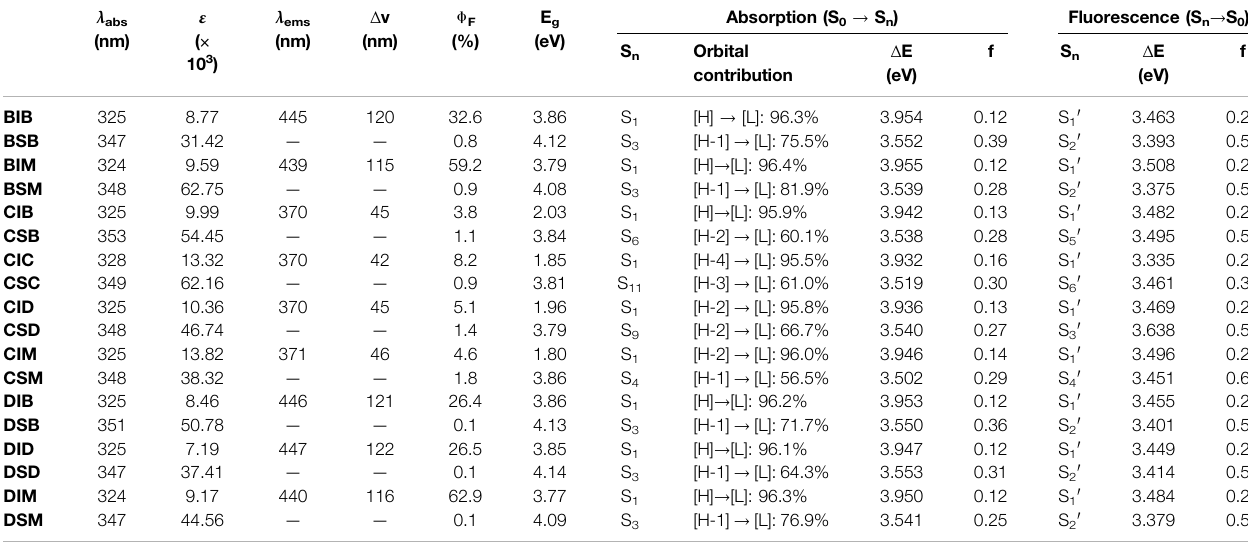
TABLE 2 | Photophysical properties of R 1 IR 2 and R 1 SR 2 according to ACN and computational calculations. λ abs